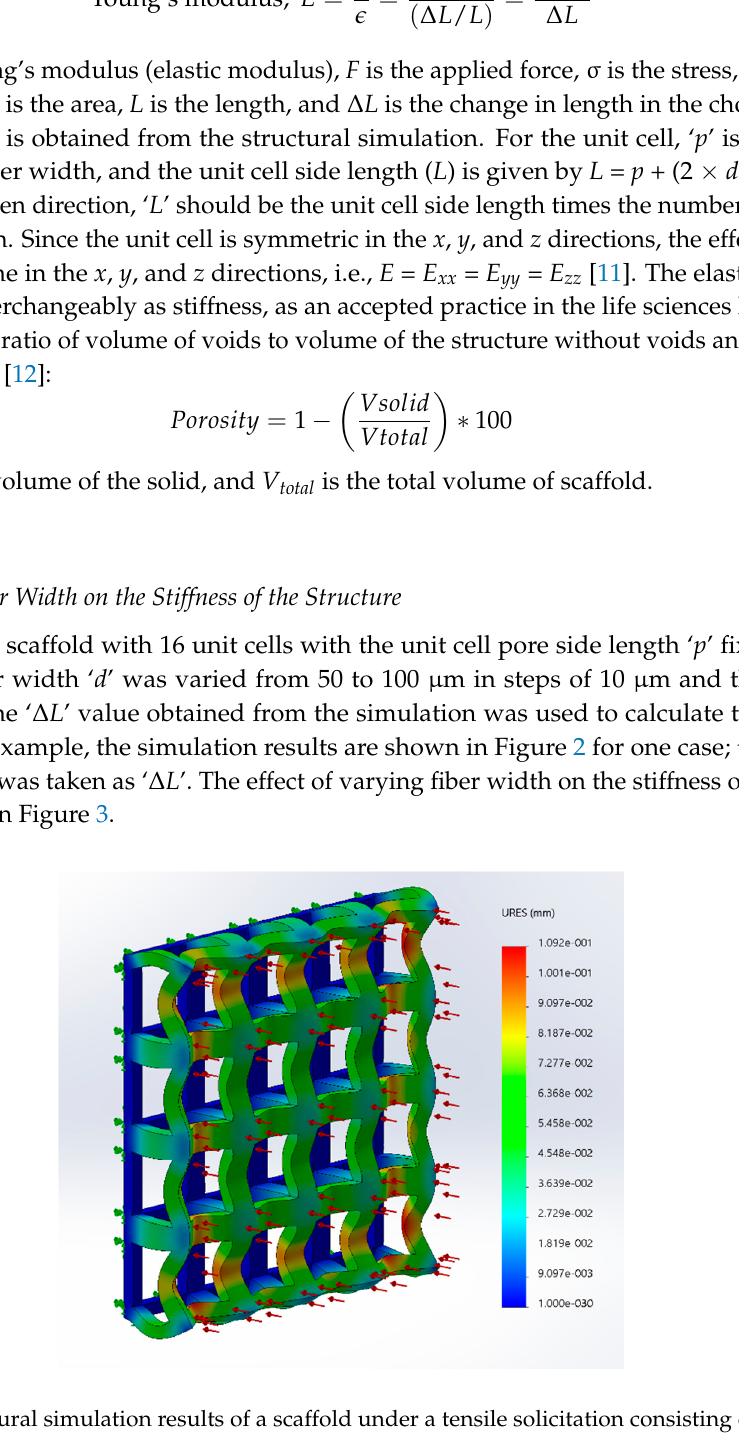
Figure 2. Structural simulation results of a scaffold under a tensile solicitation consisting of a single layer with 16 unit cells (G5, porosity = 80%, pore side length, p = 200 μ m and fiber width, d = 80 μ m).